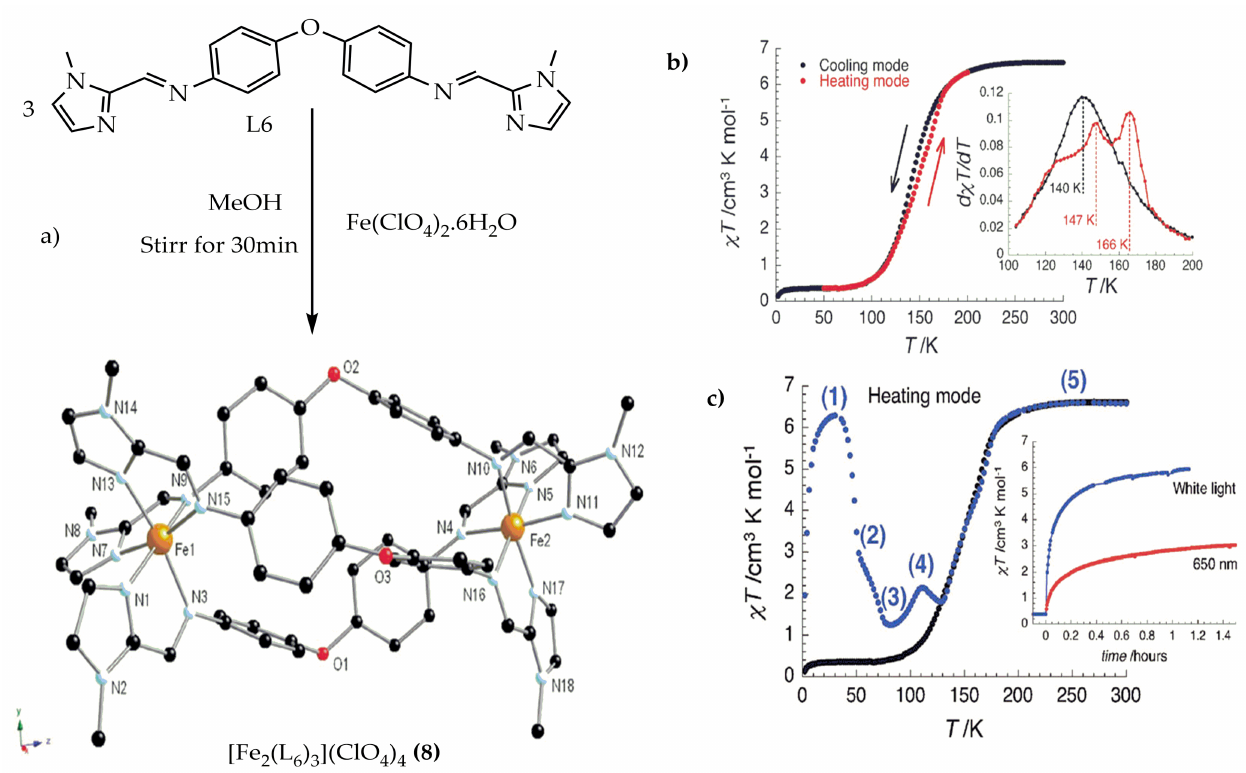
Figure 7. ( a ) Molecular structure of the triple helicate of complex ( 8 ) ( b ) χ M T vs. T plot for 8 .2MeCN at 1000 Oe at sweep rate of 0.6 K/min. Inset: dxT/dT vs. T plot ( c ) Temperature dependence of the χ M T product after white light irradiation at 10 K for ( 8 ). Inset: and white light irradiations at 10 K (at T sweep rate of 0.6 K/min). Reproduced with permission from [71]; Published by Royal Society of Chemistry,